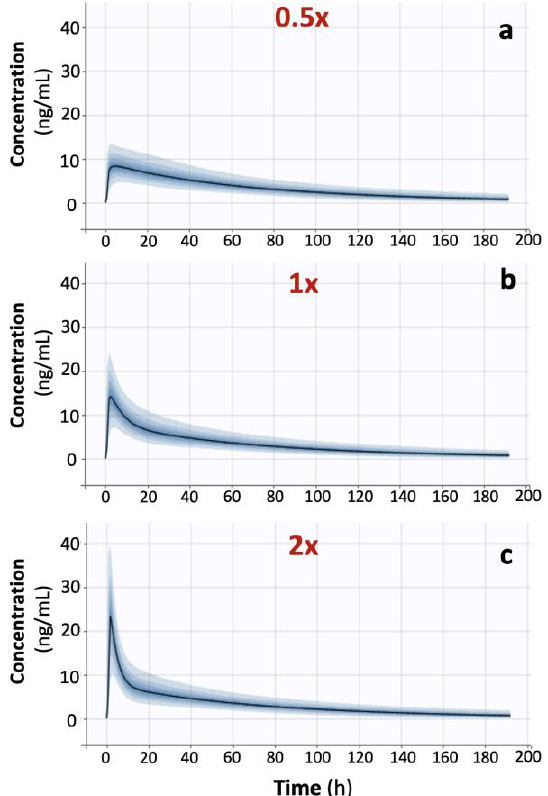
Figure 5. Simulated concentration vs. time profiles of donepezil using three different absorption rate constant average (Ka) values: ( a ) half of the true Ka estimated from the population modeling, ( b ) equal to the true Ka, ( c ) twice the value of the actual Ka. In each group, 26 subjects were generated in a 2 × 2 crossover bioequivalence study, while the sampling scheme was assumed to take place every 15 min. With the exception of Ka, all other pharmacokinetic parameters were those derived from the population modeling.